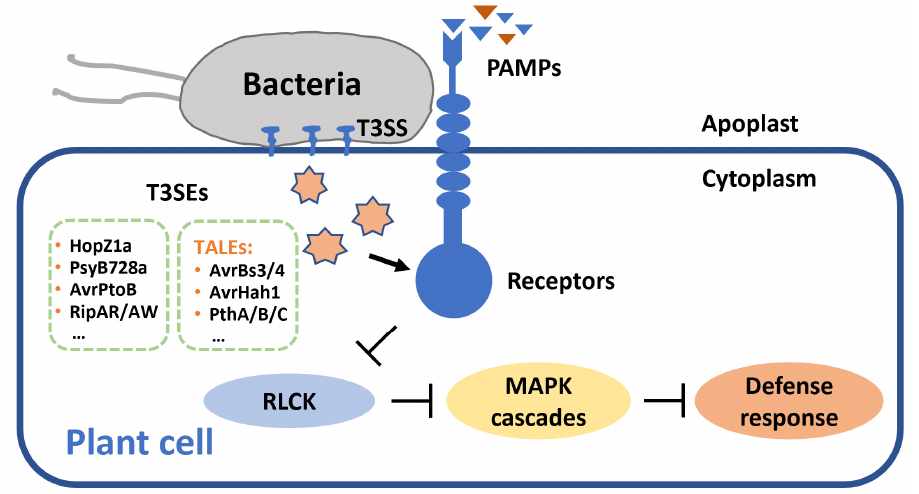
Figure 1. Bacterial pathogens secrete T3SEs targeting receptors and suppress host defense response.